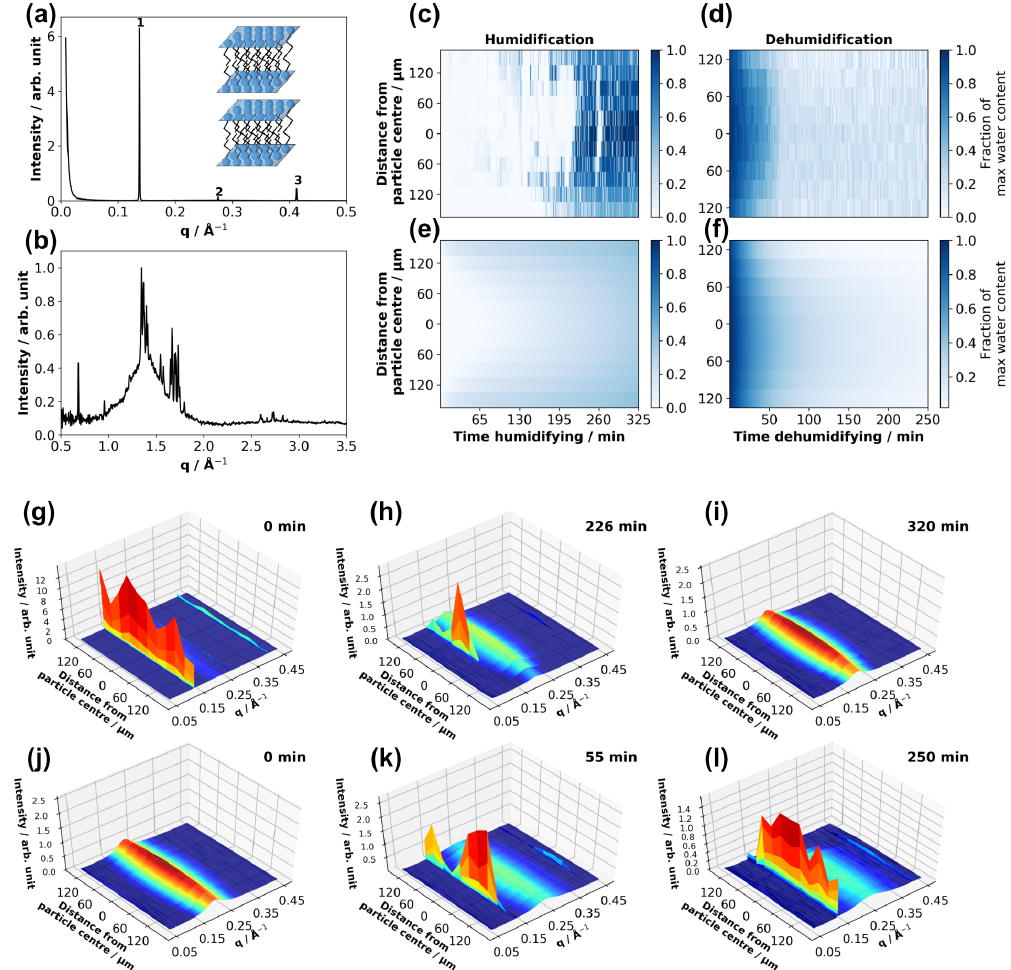
Figure 1. (a, b) One-dimensional SAXS and WAXS patterns obtained from a dry levitated particle of the acid–soap complex – first, second and third lamellar peaks are labelled, and a cartoon of the lamellar phase is presented (a) . (c, d) Experimental fraction of maximum water content as a function of distance from particle centre and time humidifying and dehumidifying. (e, f) Modelled fraction of maximum water content – best fits to experimental data for humidification and dehumidification; 3-D surface plots of 1-D SAXS patterns plotted against distance from the particle centre for the same particle humidifying (g–i) and dehumidifying (j–l) , with time humidifying and dehumidifying presented at the top right of each plot (particle size: ∼ 150µm (vertical radius) × 500µm (horizontal radius); humidification experiment: ∼ 38% (room RH) (g) to 90% RH (h, i) ; dehumidification experiment: 90% (j) to ∼ 38% RH (k, l)